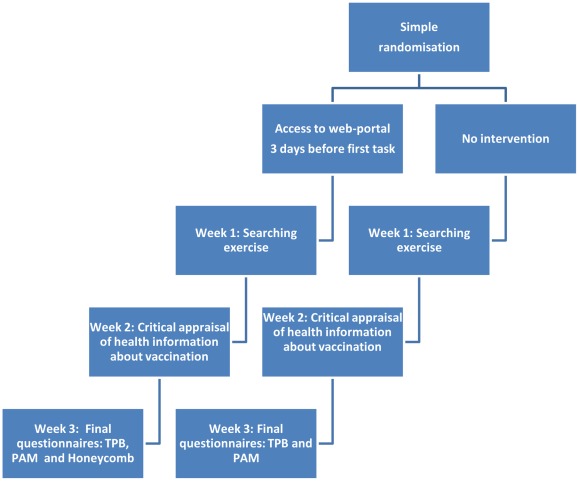
Overview of the study design.